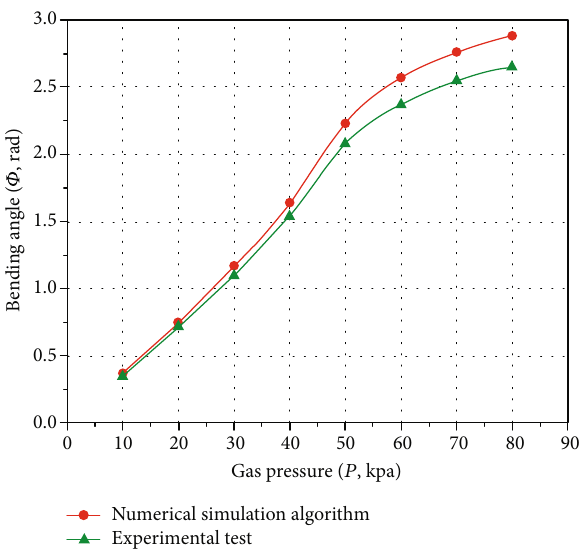
Figure 15: Errors analysis of numerical simulation deformation